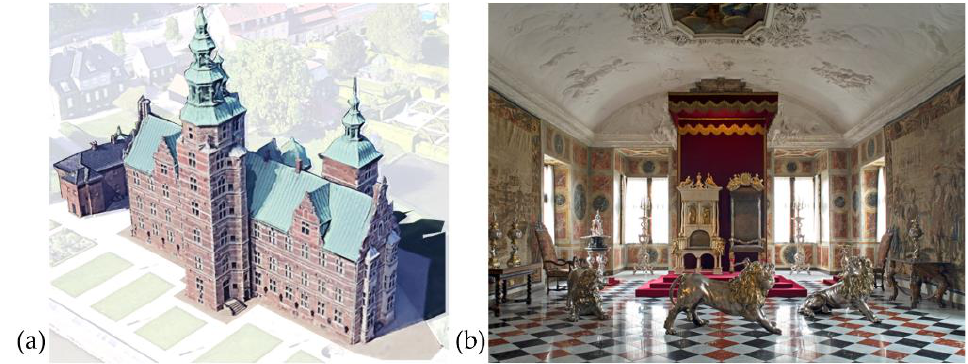
Figure 1. Rosenborg Castle: ( a ) 3D sketch of the external view; ( b ) the Great Hall (Room 21) located on the second floor.